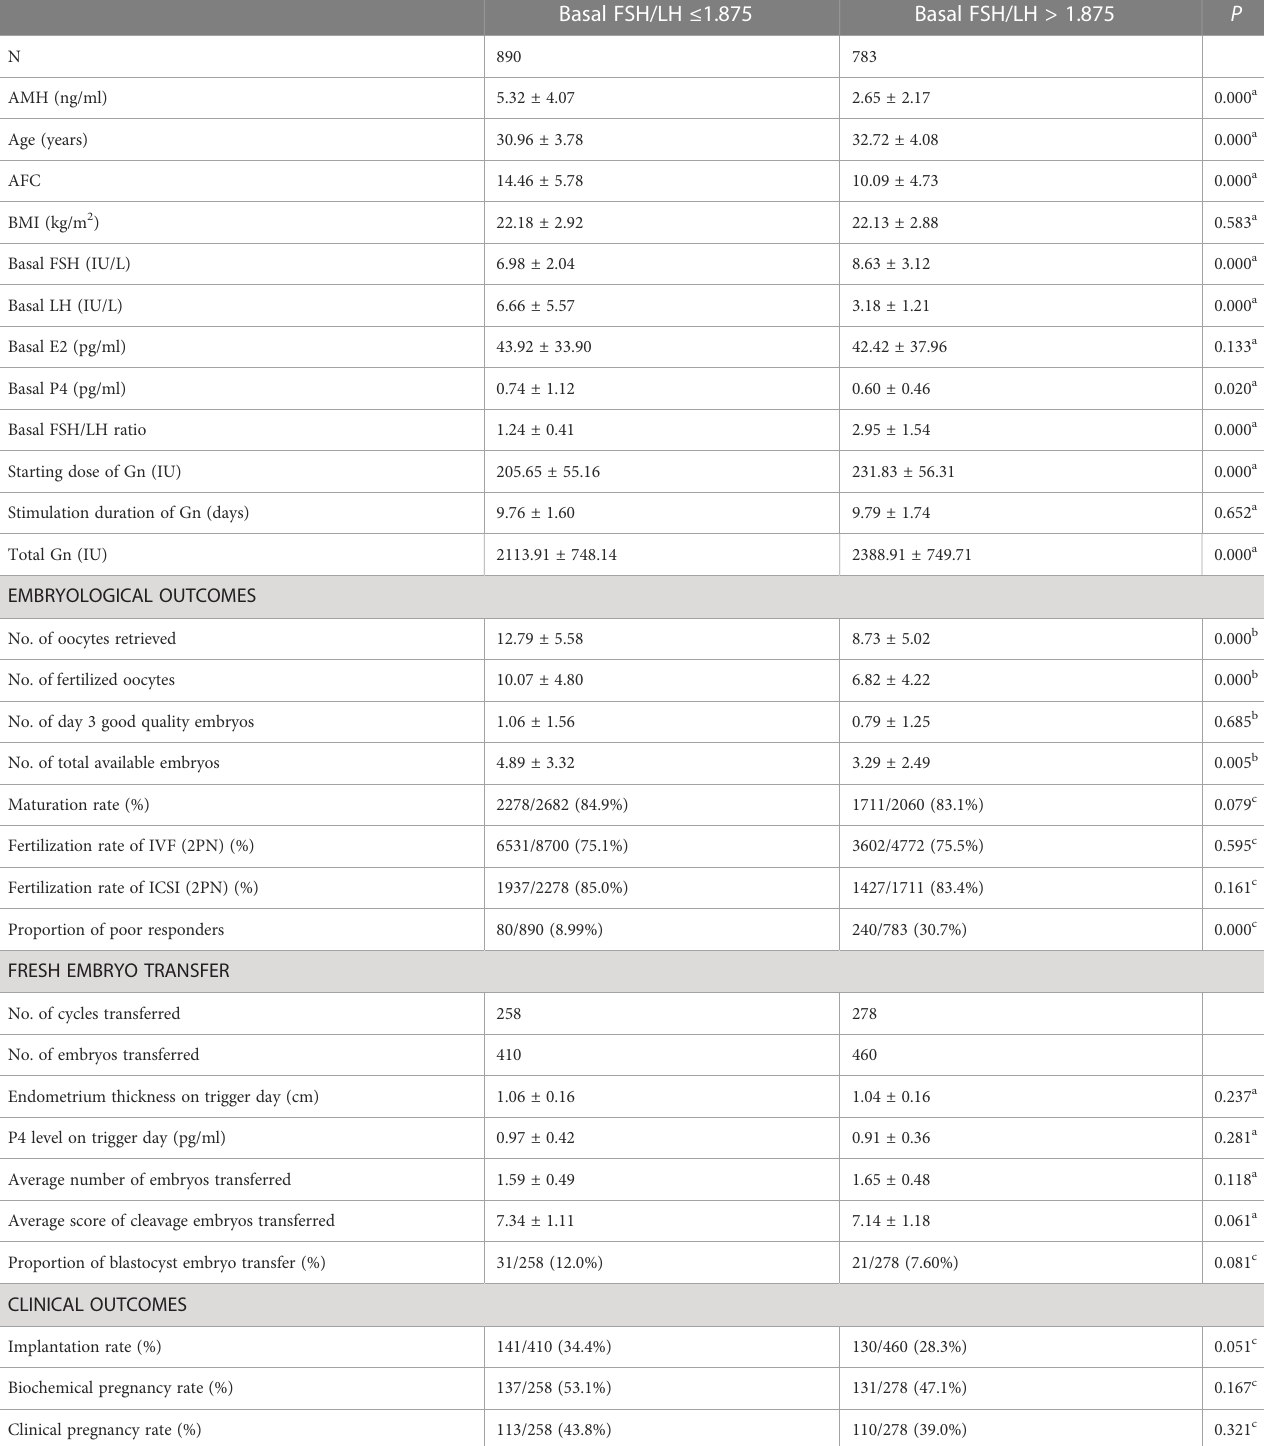
TABLE 2 Basic characteristic, embryological outcomes and clinical outcomes of subgroups based on the basal FSH/LH ratio cutoff value for poor responders. Basal FSH/LH ≤ 1.875 Basal FSH/LH >